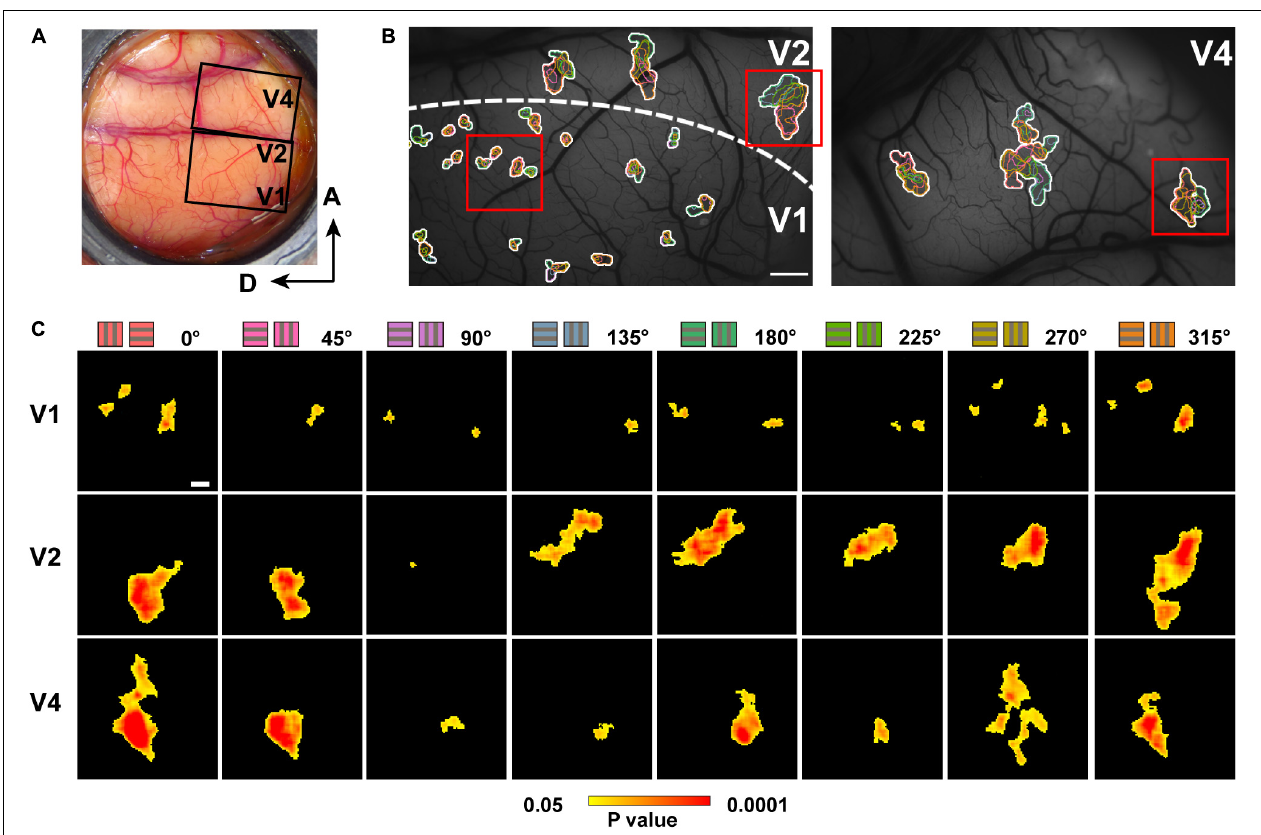
FIGURE 3 | Hue domains and hue clusters in V1, V2, and V4. (A) A view of the exposed cortex over V1, V2 and V4 (Case 2). (B) hue domains (color contours) and hue clusters (white contours) in V1, V2, and V4 are displayed from the black framed region in (A) . Scale bar: 1 mm. (C) Examples of hue domains that responded significantly more strongly to stimuli of each hue (indicated on the left) compared to achromatic stimuli in V1 (left), V2 (middle), and V4 (right; pixel-wise two-tailed t test, n = 160, P < 0.05 and the peak P < 0.001, uncorrected). These were obtained from the regions framed in red in the respective visual areas in (B) . Scale bar: 100 µ m. The color bar at the bottom shows a scale of P values on a log